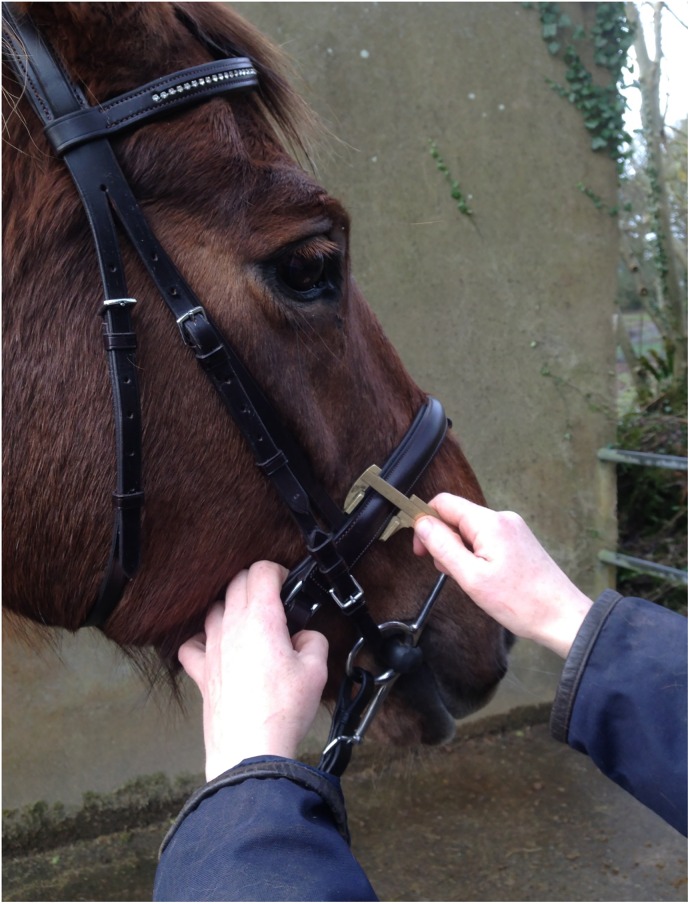
Use of TB callipers to measure the width of the noseband (mm).